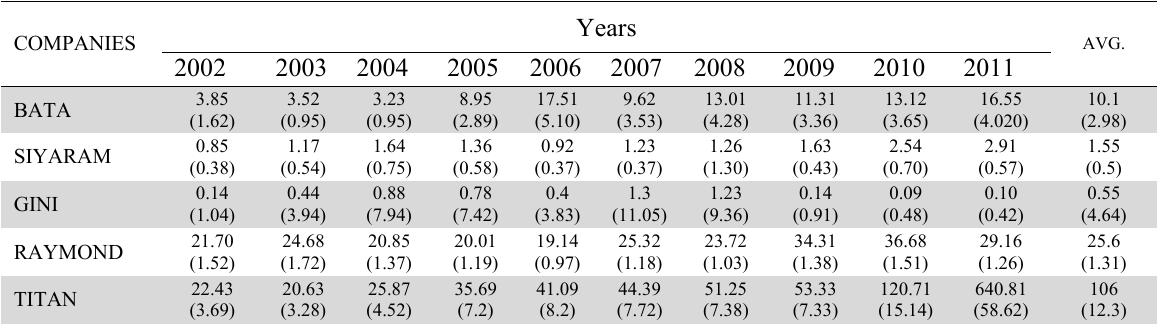
Rs. in crore (also in % of total assets)